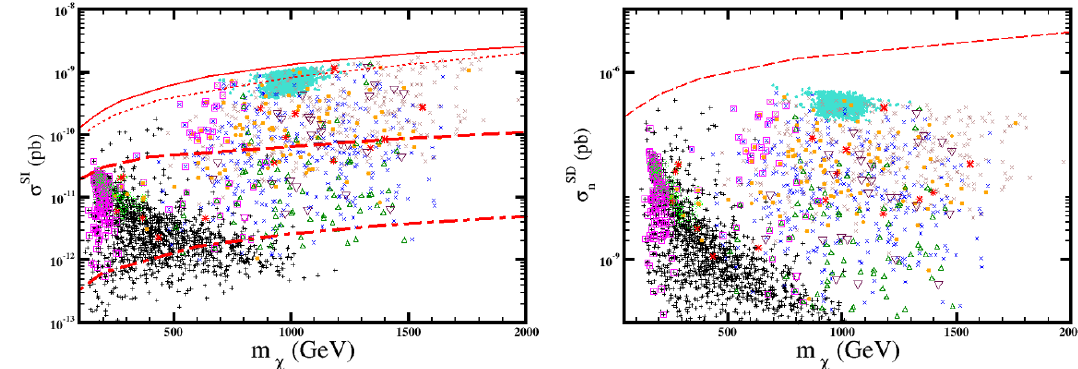
Figure 5 . Left panel: scatter plot for the SI neutralino-nucleon cross section; the upper red line corresponds to the Xenon-1T bound [12] and the dotted line below, to its recent update [81].The dash and the dot-dash lines correspond to the projected sensitivities from LZ [10] and DAR- WIN [13]. Right panel: same plot for the SD neutralino-neutron cross section and the projected limit from LZ